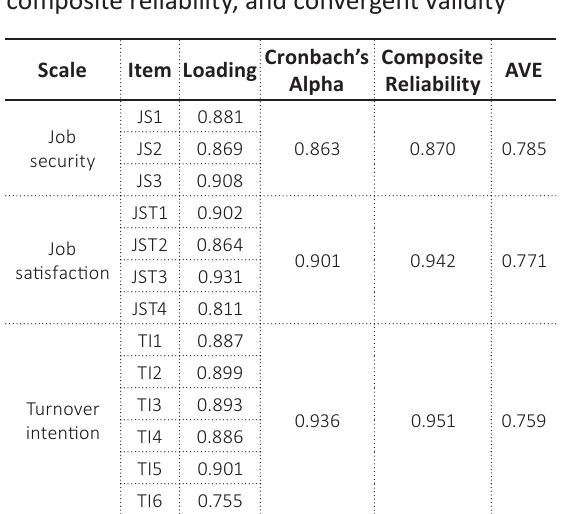
Table 2. Factor loadings, items, Cronbach’s alpha, composite reliability, and convergent validity